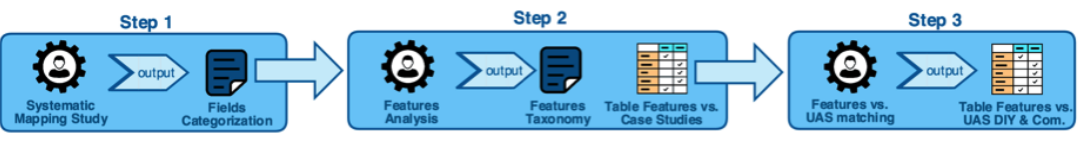
Figure 1. Process for identifying sustainable UAS necessity in a